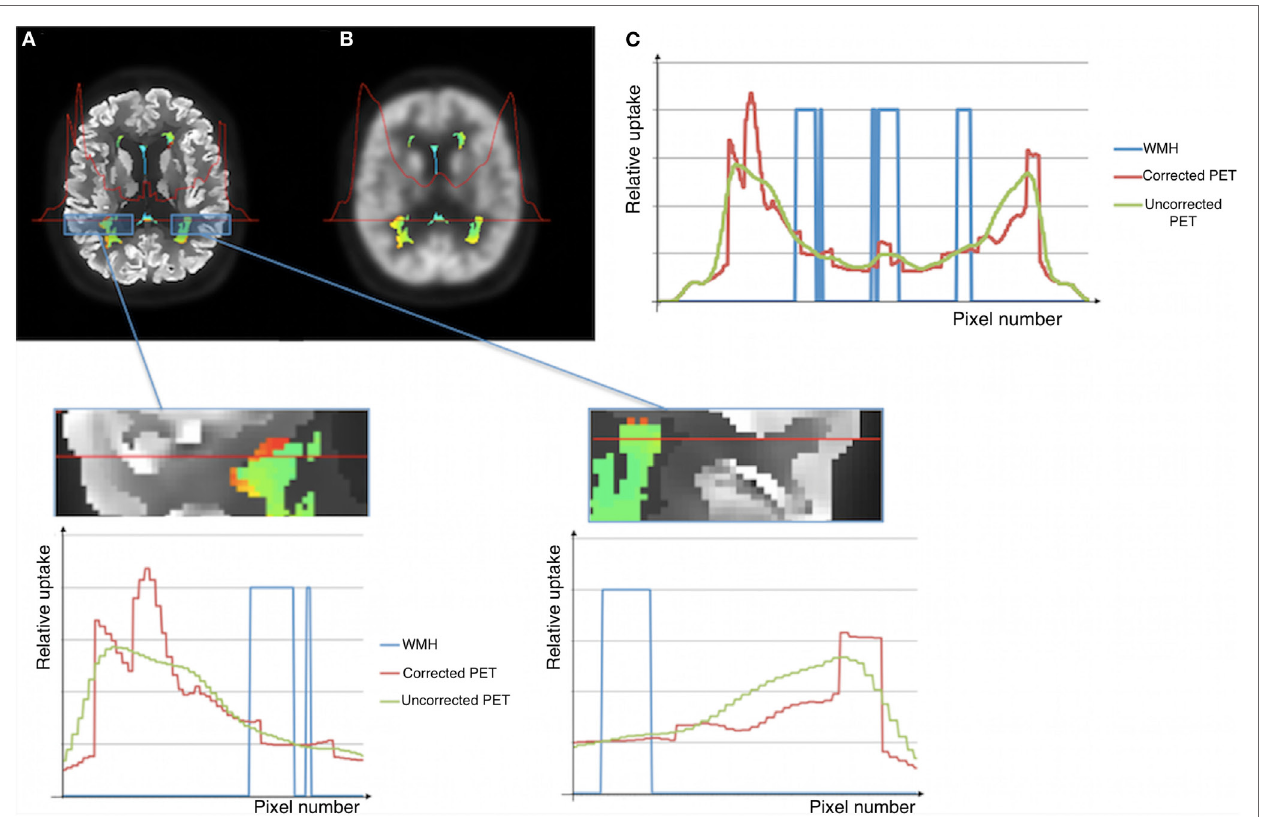
FigUre 4 | illustration of corrected (a) and uncorrected (B) images for effects of partial voluming . WMHs PET intensities and the metabolic profile for the selected WMH section across the brain shown in (c)